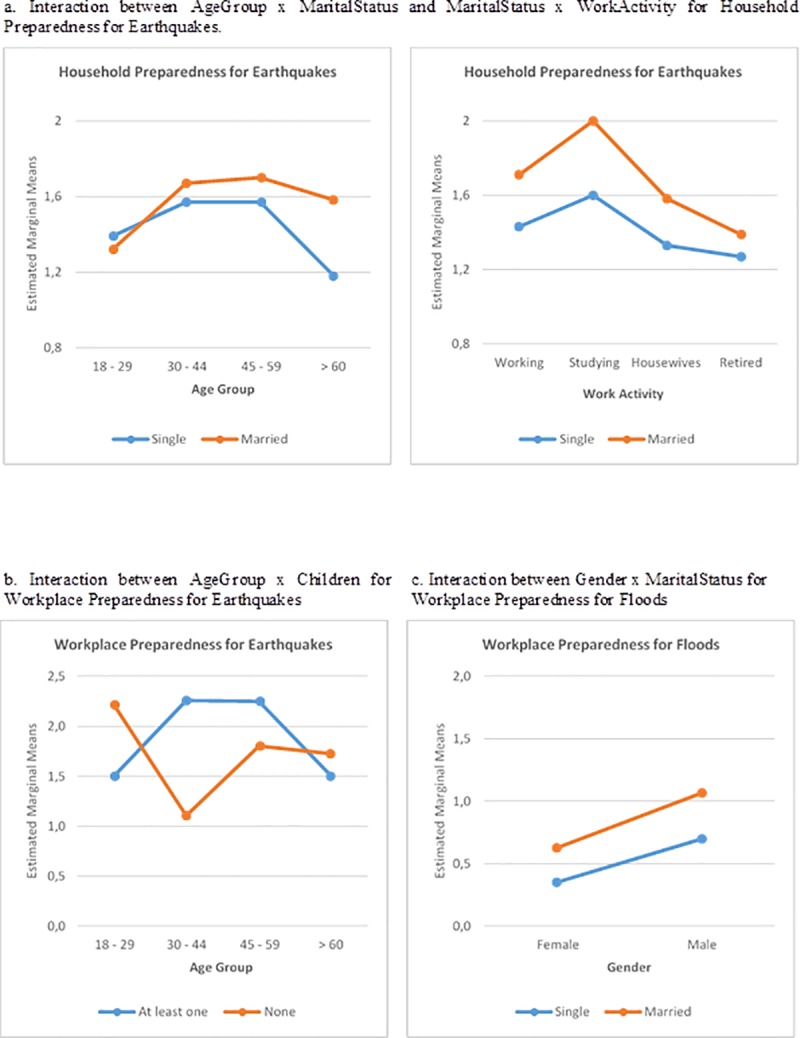
Interaction plots for household and workplace preparedness for earthquakes and floods.